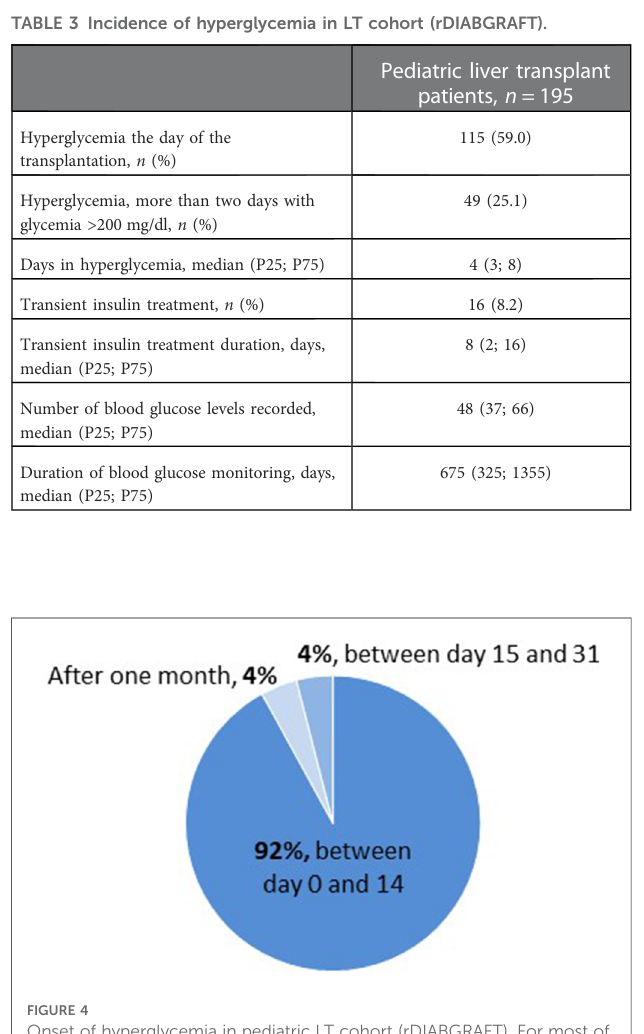
corresponding to overt diabetes ( Figure 8 ). Dosage of pro-insulin and C-peptide showed that no patient presented a β -cell dysfunction whereas HOMA-IR showed severe IR (HOMA-IR >2.4) for all our RT patients ( Table 8 ). At three-, six- and nine- months post-RT, all patients had normalized their glycemia at the end of the test (<140 mg/dl) ( Figure 8 ), but they had continued to present moderate and severe IR except one at nine- month ( Table 8 ).